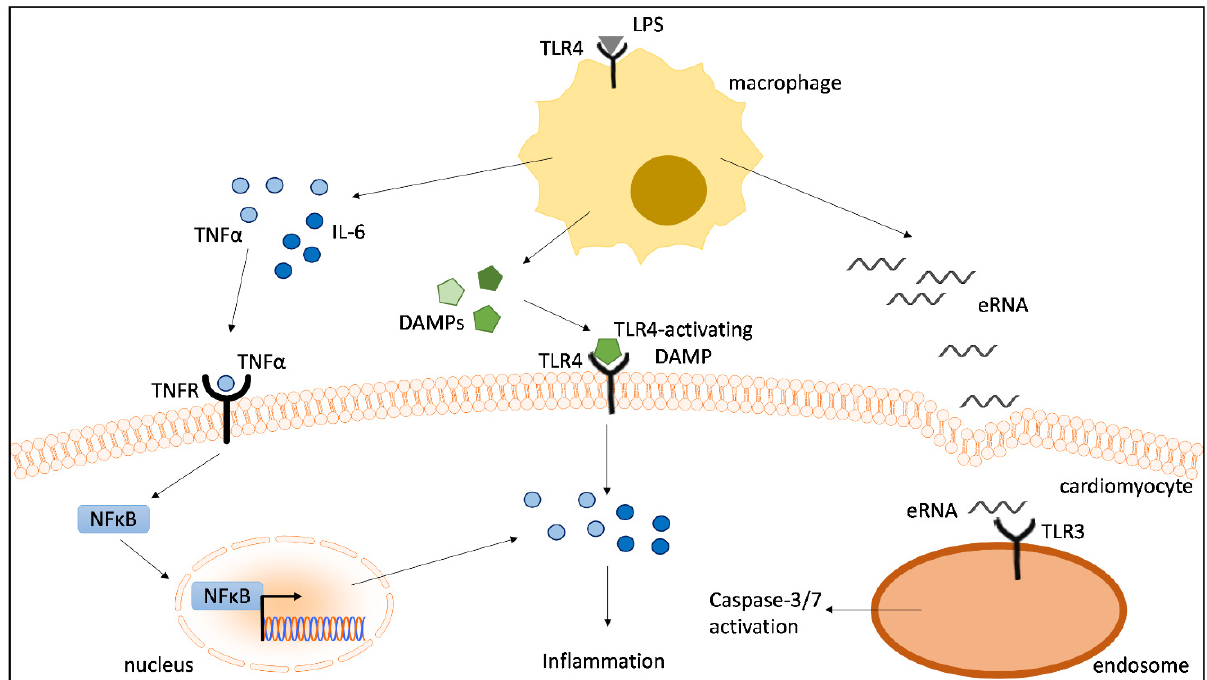
Figure 7. Proinflammatory macrophages induce cardiac inflammation and caspase 3/7 activation. Cytokines, eRNA and other unknown DAMPs released from LPS-stimulated macrophages contribute to cardiac inflammation via the activation of TLR4- and TNFR-dependent NF κ B translocation as well as to TLR3-mediated cardiac caspase-3/7 activation. LPS = lipopolysaccharide; TLR = toll-like receptor; TNFR = tumor necrosis factor receptor; NF κ B = nuclear factor kappa-light-chain-enhancer of activated B-cells; IL-6 = interleukin-6; TNF α = tumor necrosis factor alpha; eRNA = extra- cellular RNA.